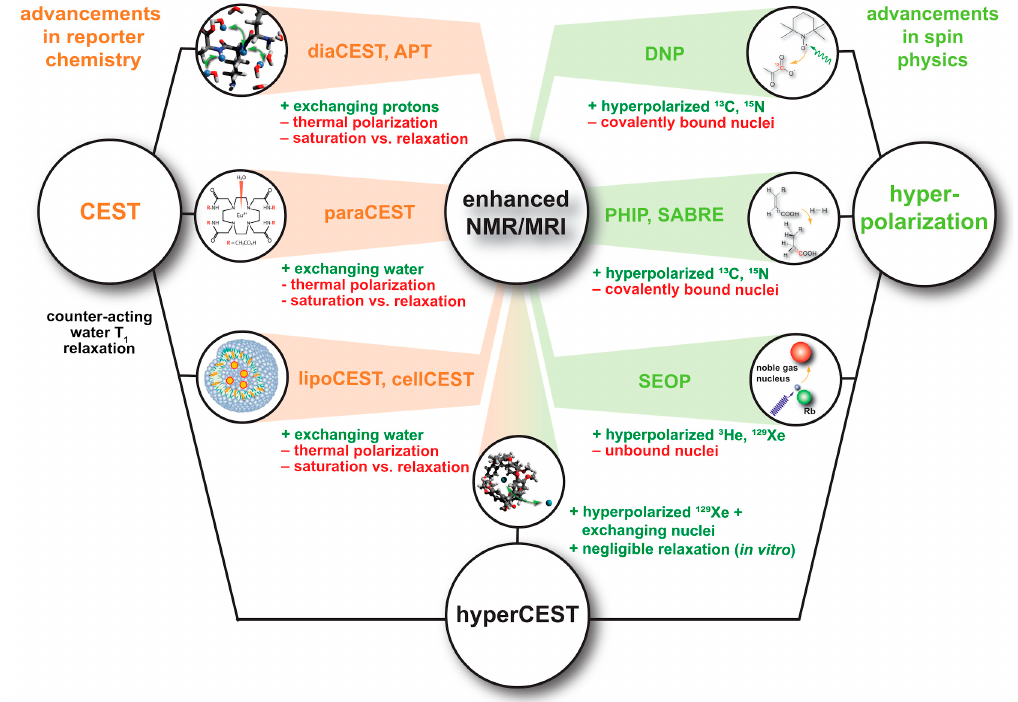
Figure 4. HyperCEST combines advantages from advancements in reporter chemistry and spin physics, i.e., the enhanced magnetization from a pre-polarized spin system plus the efficient use of exchanging nuclei to transfer information from a dilute to a bulk pool. Pros and cons for each technique are shown in green and red, respectively. Thermally polarized CEST systems are typically limited by the counter-acting T 1 relaxation that limits the achievable saturation effect.